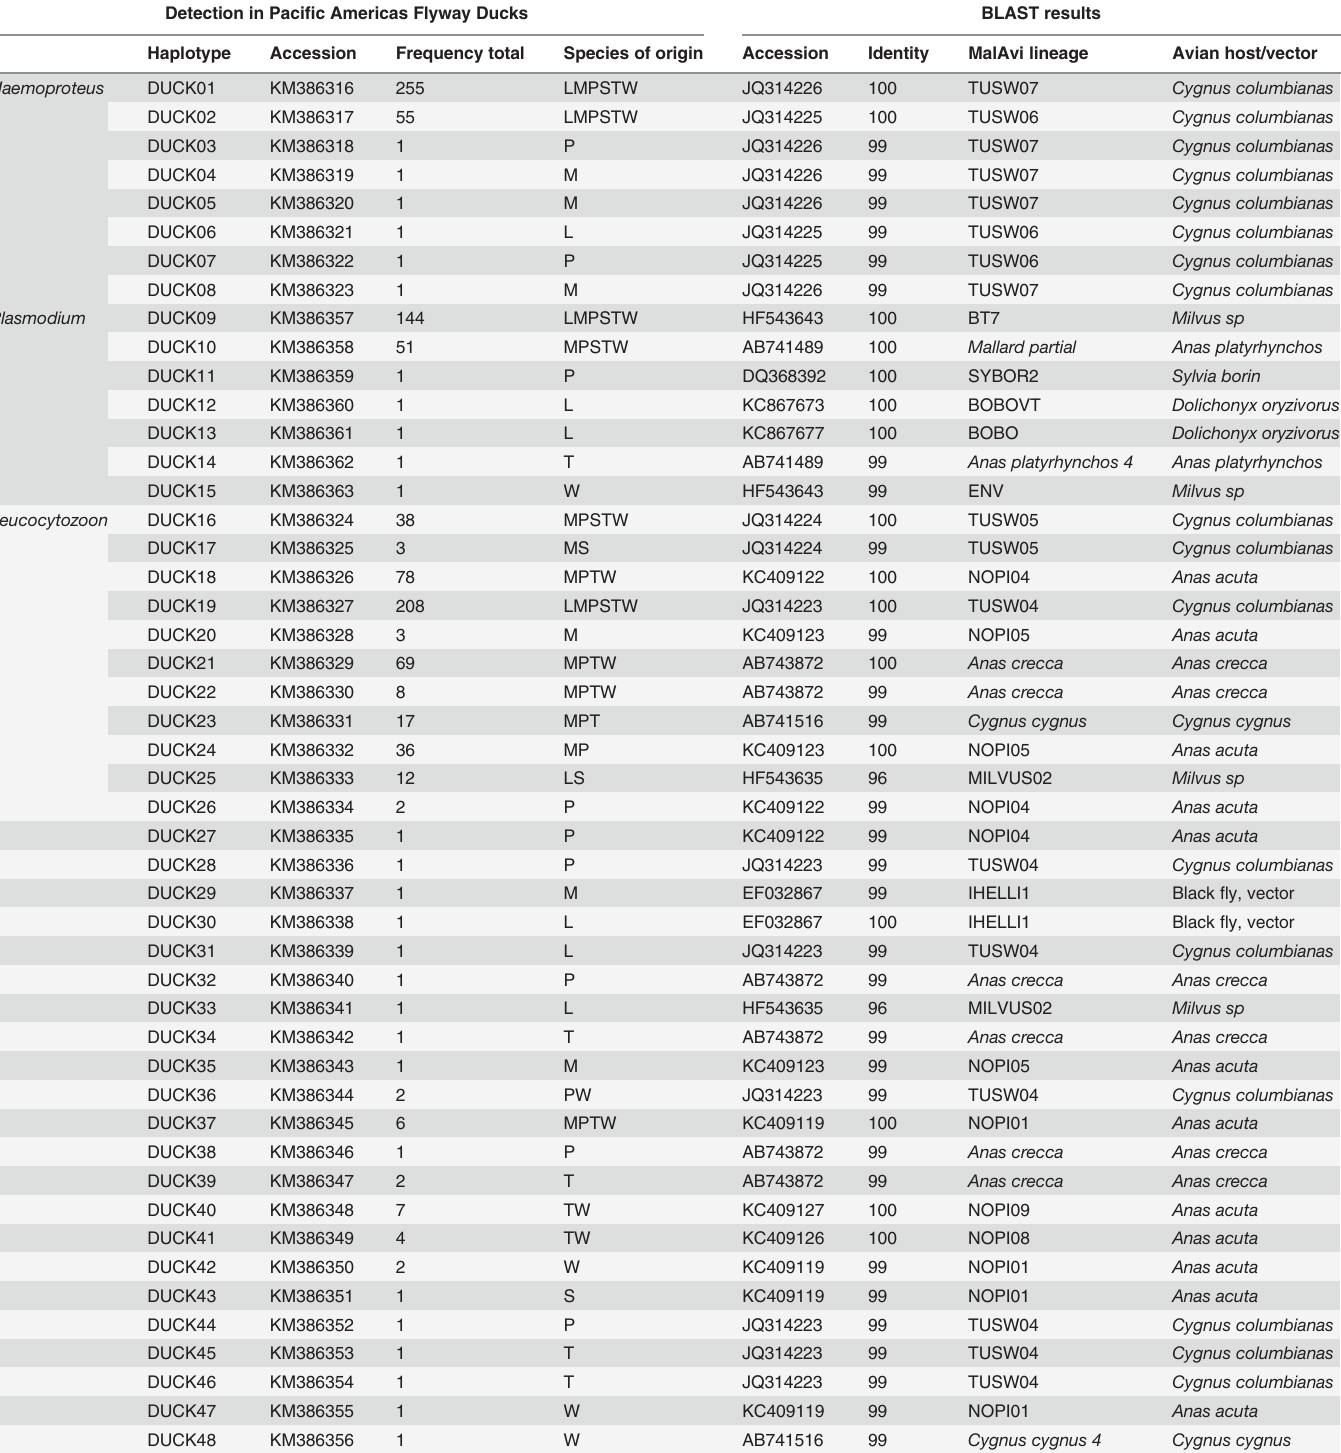
Table 2. Summary of haplotypes identi fi ed in this study, the corresponding frequency at which they were identi fi ed, and host species within which they originated (L = Lesser Scaup, M = Mallard, N = Northern Pintail, S = Northern Shoveler, T = American Green-winged Teal, W = American